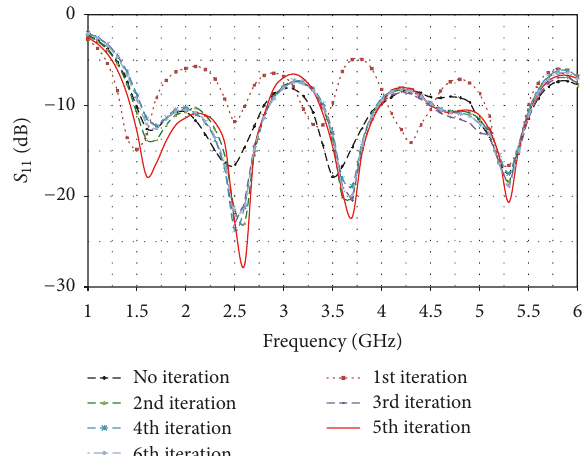
Figure 4: Combined simulated return loss for the antenna iterations.